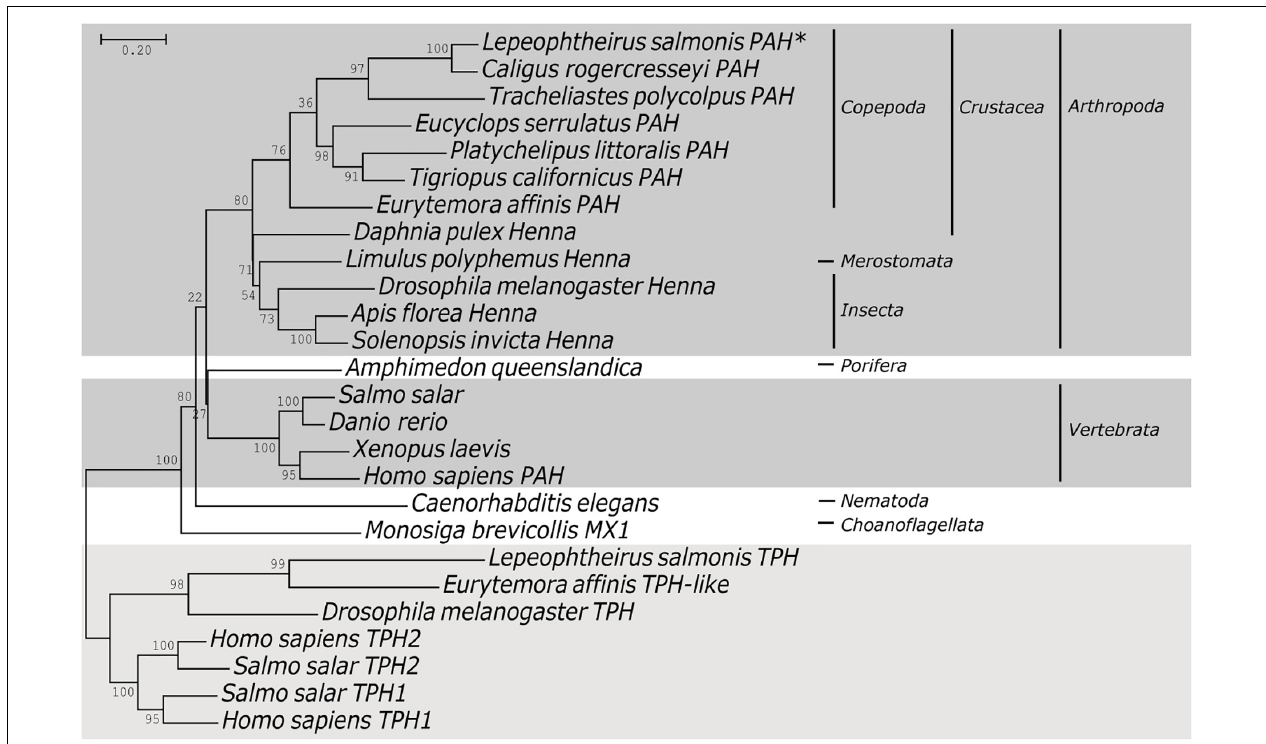
FIGURE 2 | Phylogenetic tree of PAH proteins. Phylogenetic analysis of phenylalanine hydroxylase (PAH) among different organisms. A Maximum Likelihood tree was generated using MEGA7, with bootstrap values from 1000 replications. The sequences used for the construction of phylogenetic trees are listed in Supplementary Table 2